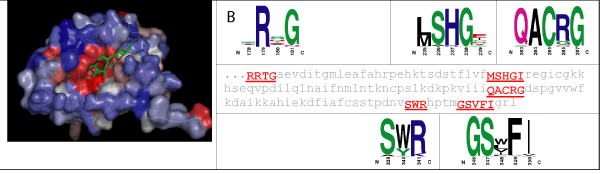
Constructing a set of sequence profiles to represent a conserved structural feature. Caspase's active site is highly conserved (1ICE, conservation levels are calculated using the von-Neumann entropy and displayed in a color gradient from blue (variable) to red (conserved)). Conserved residues in close vicinity of the tetrapeptide inhibitor largely define the catalytic site environment. Caspase residues within 5 Å of the inhibitor are underlined. Segments are patched and those with low conservation are discarded to avoid insignificant hits. We add the amino acid distribution from HSSP data for each site of the remaining segments. It is thus possible to construct HMMs and visualize the profiles as sequence logos [40].